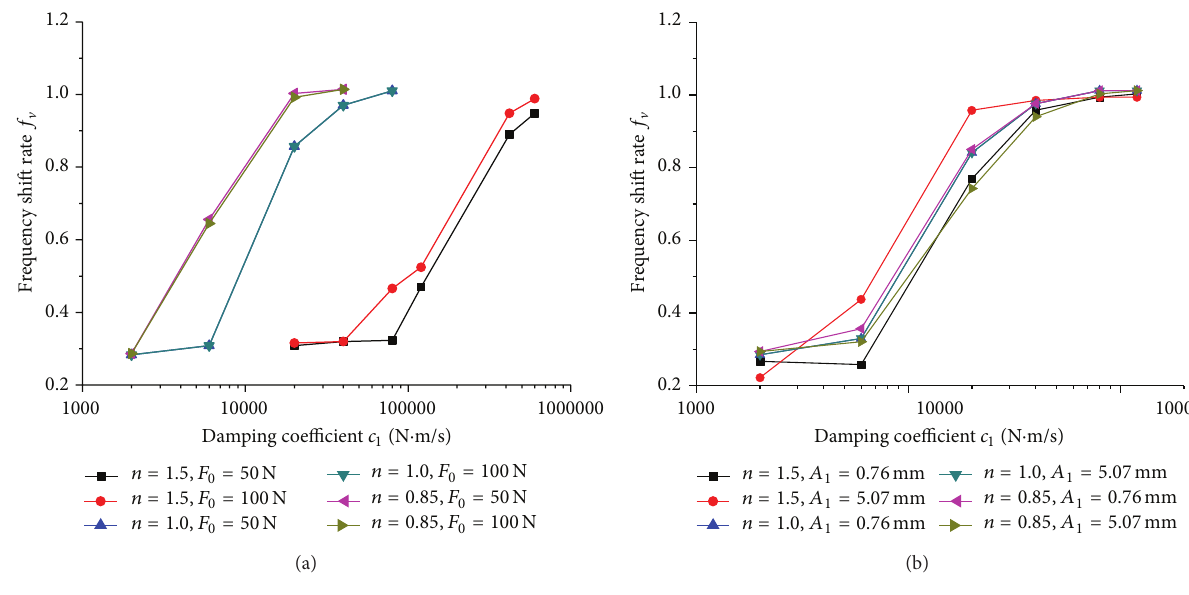
Figure 22: Frequency shift rates of CM. (a) FE cases; (b) FDE cases. Table 1: Table head of L (6). 25